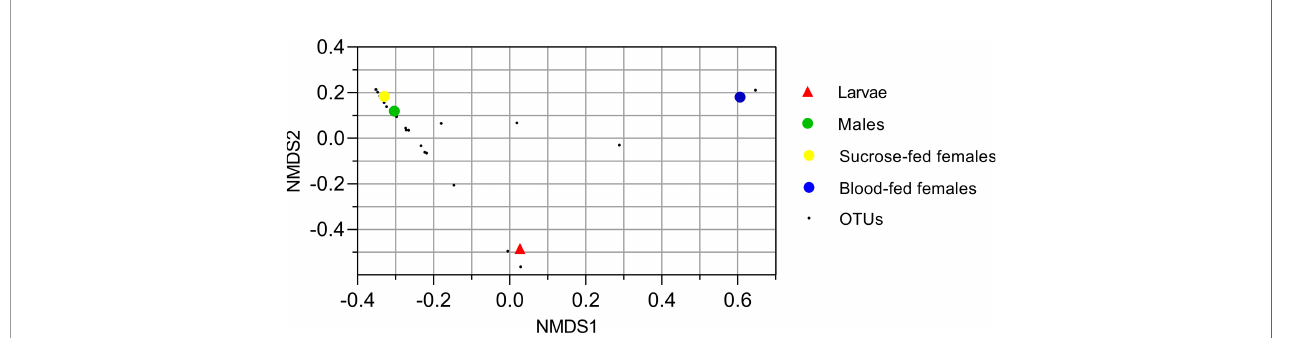
FIGURE 2 | Nonmetric multidimensional scale ordination plot of groups based on Bray-Curtis dissimilarity matrix. Fungal operational taxonomic units (OTUs) are represented with small black points. Larvae, male and sucrose-fed females are in